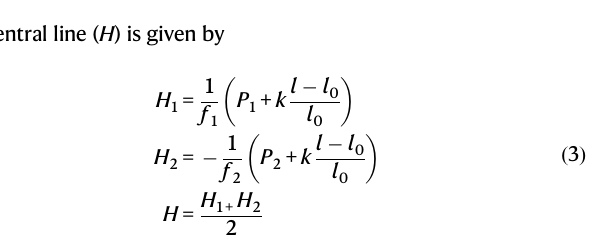
(junction coverage, h ). Below graphs, micropattern geometries are represented as red circles, green squares and orange triangles. Number of independent biological replicates are: N =4 ( a – d ); N =3 ( e ); N =7 ( f – h ). Number of cell pairs assessed is shownontopofeachgeometricshape( a – d ; f – h ).Meanvaluesanderrorbars(SEM) areshown( e – h ).Statisticalanalysiswasperformed by t -testwithWelch ’ scorrection (unpaired,two-tailed, e )orone-wayANOVAfollowedbyKruskal – Wallispost-hoctest and Benjamin, Krieger and Yekutieli test ( f – h ). In panels a – d , two-way ANOVA test was performed followed by Sidák ’ s multiple comparisons to test for interactions. Similarly, Wilcoxon matched paired test for each cell pair comparison showed sig- ni fi cant differences for all samples (values shown in Source data). Source data are provided as a Source Data fi